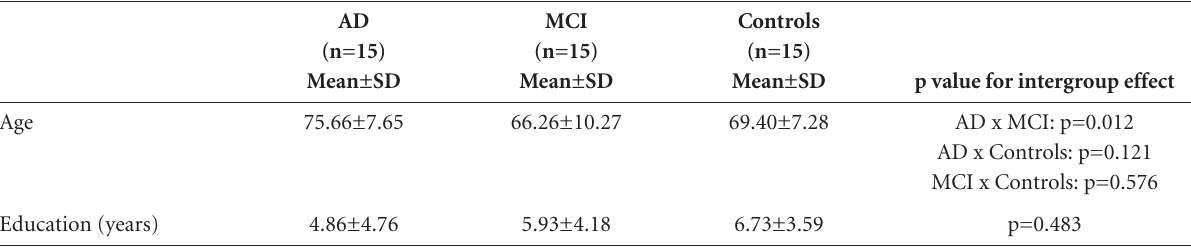
Table 1. Demographics results of amnestic mild cognitive Impairment (AMCI), Alzheimer disease (AD), and normal control subjects.